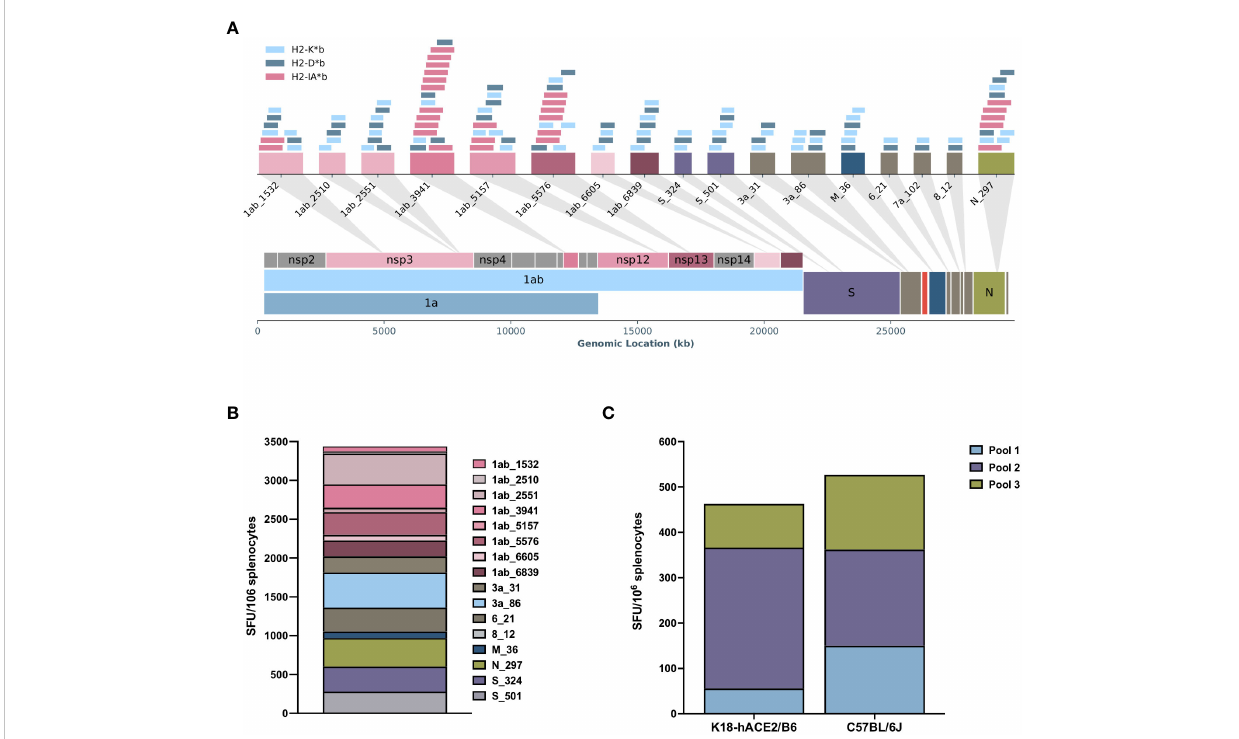
FIGURE 1 The RAVEN ™ (Rapidly Adaptive Viral rEspoNse) antigen-presenting cell targeting (APCt)-CoV2-T vaccine induces speci fi c T-cell responses in C57BL/ 6J and K18-hACE2/BL6 mice. (A) Schematic overview of the in silico RAVEN predicted T-cell hotspots encoded in the APCt-CoV2-T-cell vaccine. A T-cell hotspot represents a region with several predicted major histocompatibility complex (MHC) class I (H2-Kb, H2-Db) and MHC class II (H2-Iab) binders. (B) IFN- g enzyme-linked immunosorbent spot (ELISpot) of splenocytes from APCt-CoV2-T-vaccinated C57BL/6J mice ( n = 4) shows a response to 15 of the 17 peptide hotspots included. (C) IFN- g ELISpot using peptide pools for stimulation of splenocytes from C57BL/6J ( n = 3) and K18-hACE2/BL6 ( n = 4) mice show a comparable response to the APCt-CoV2-T vaccine. No response was noted for APCt-mock-vaccinated animals (data not